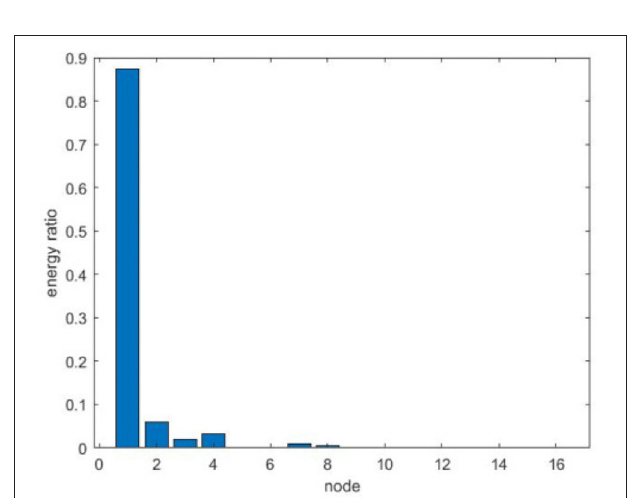
FIGURE 2 | Energy ratio of 4-layer wavelet packet